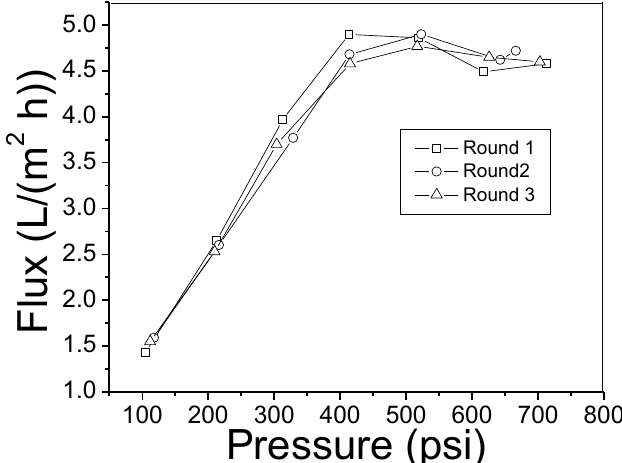
Figure 10 . Pure water flux of PBI HF module (air gap = 2.5″, 6.4 cm) varied by hydraulic pressure.